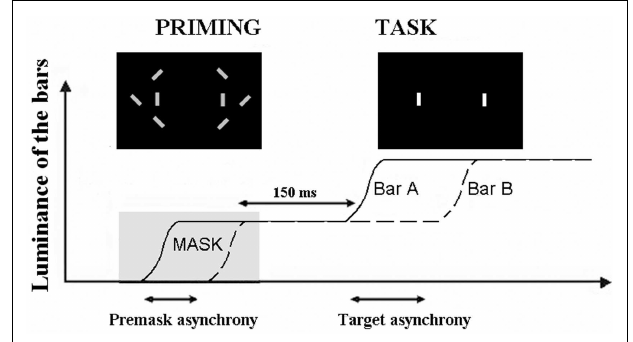
FIGURE 1 | Illustration of the paradigm used to check for a non-specific effect of subjective judgments .The curves represent the increase in luminance of the two target bars, A and B.The first increase in luminance is used as a prime and masked by the distracters (“priming” figure).The prime is asynchronous when the two bars increase their luminance asynchronously.The task of the participant is to decide whether the second increase in luminance is simultaneous or asynchronous (with the permission of Schizophrenia Bulletin).